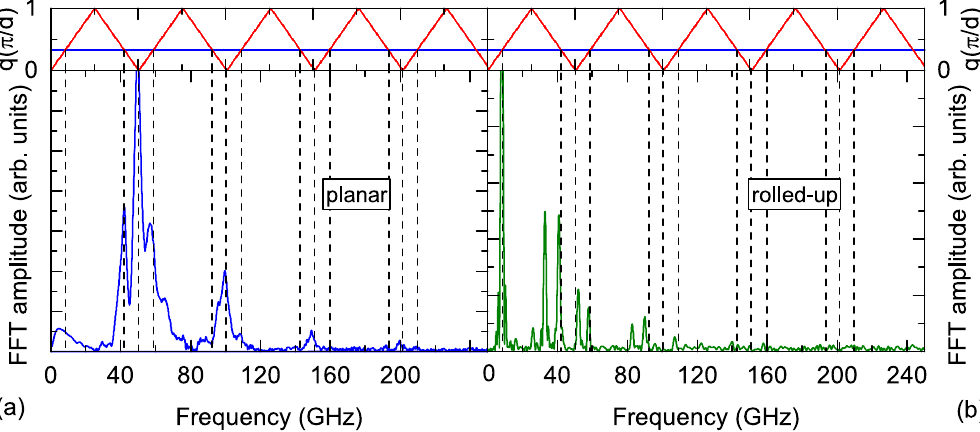
Figure 3. ( a ) The top part of the figure reveals the calculated back folded acoustic phonon dispersion relation (red line) with the observed 2 q probe modes at the intersection of the 2 q probe line (horizontal blue line) and the dispersion relation. The bottom part displays the FFT of sample A 5MBE , the MBE grown SL with 5 layers of GaAs and In 0.2 Ga 0.8 As. Dashed lines indicate the eigenmode frequencies calculated by the Rytov model. ( b ) Similar to ( a ), but for the experimental results of the rolled-up SL of sample A r .